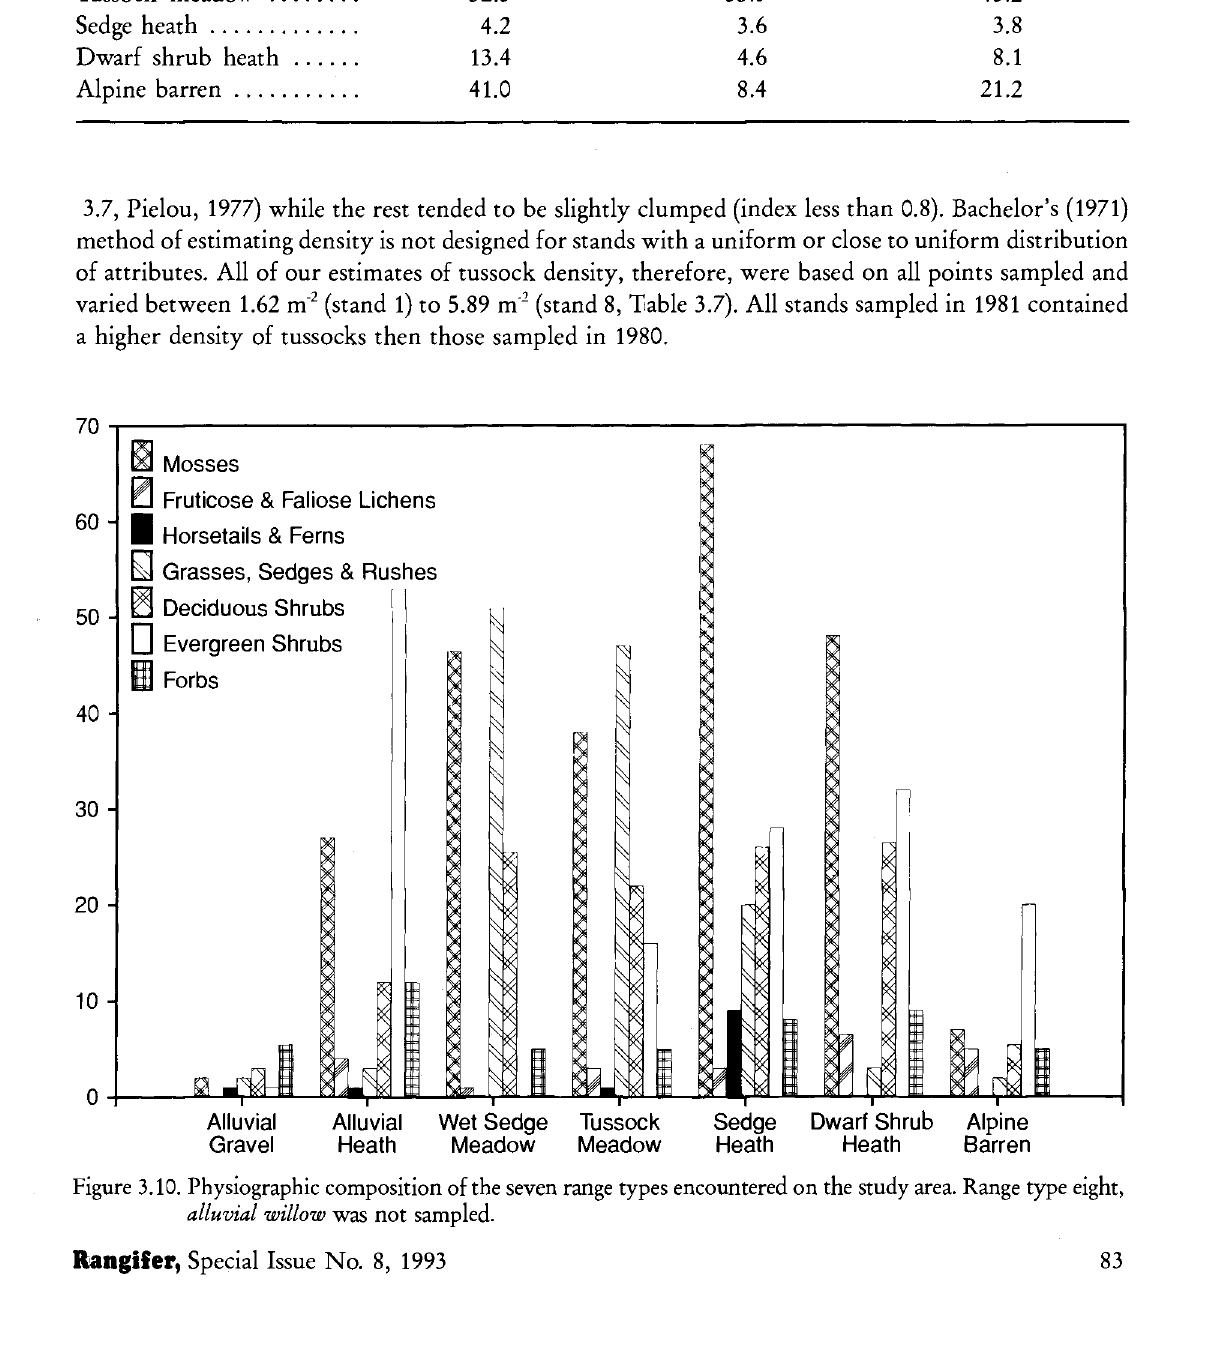
Figure 3.10. Physiographic composition of the seven range types encountered on the study area. Range type eight, alluvial willow was not